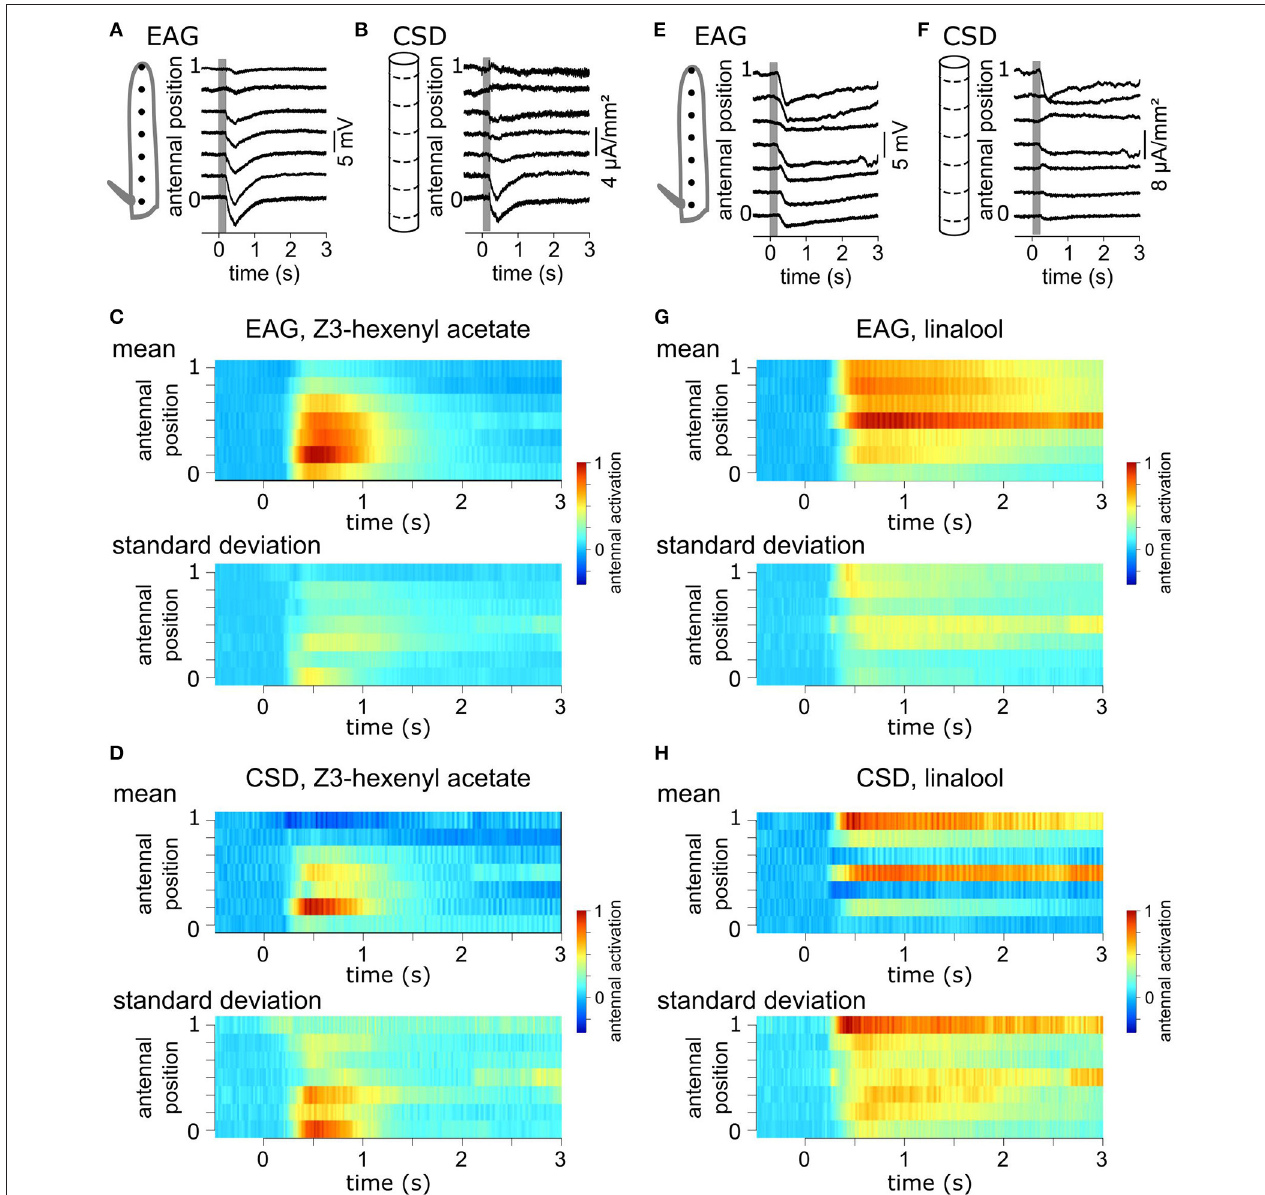
FIGURE 2 | Antennal response maps estimated with the CSD analysis. (A) EAGs were recorded in response to puffs of Z3-hexenyl acetate and with the electrode located at seven positions on the funiculus of a Z. cucurbitae female along the proximodistal axis. Gray area indicate the stimulation time. Antennal position varied between 0 (proximal position near the arista) and 1 (distal extremity of the funiculus). The scheme in the left represent the funiculus with the position of the electrodes. (B) A model of funiculus with seven compartments (scheme on the left) was used to estimate the CSD (right) from the EAG recording shown in (A) . (C) Spatiotemporal maps of EAG recordings in response to puffs of Z3-hexenyl acetate. Both mean (top) and standard deviation (bottom) are plotted on the same color scale, normalized by the maximum EAG value ( n = 7 Z. cucurbitae females). (D) Spatiotemporal maps of CSD response to puffs of Z3-hexenyl acetate. Values were normalized by the maximum CSD value. Same convention as in (C) . (E) EAG responses of a female Z. cucurbitae to a puff of linalool. Same convention as in (A) . (F) CSD response to a puff of linalool in the individual from (D) . Same convention as in (B) . (G) Spatiotemporal EAG maps of female Z. cucurbitae in response to puffs of linalool ( n = 7). Same convention as in (C) . (H) Spatiotemporal CSD maps of female Z. cucurbitae in response to puffs of linalool ( n = 7). Same convention as in (D) . Data in this figure were included in Jacob et al. (2017b).